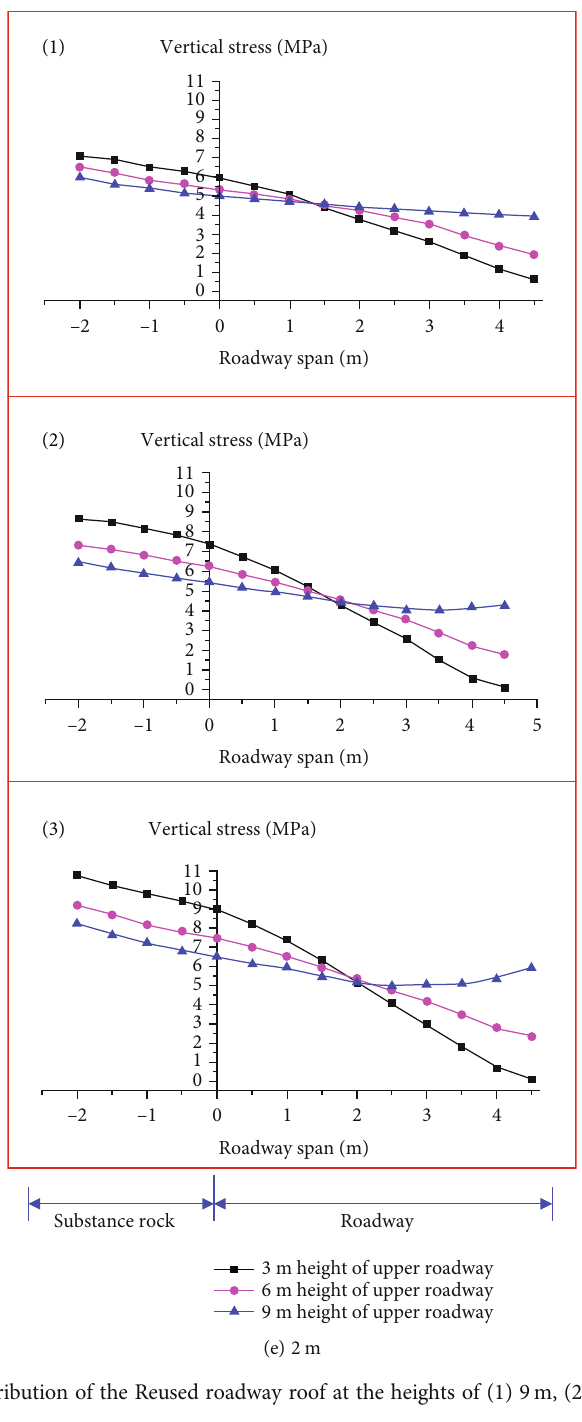
Figure 9: Stress distribution of the Reused roadway roof at the heights of (1) 9 m, (2) 18m, and (3) 27